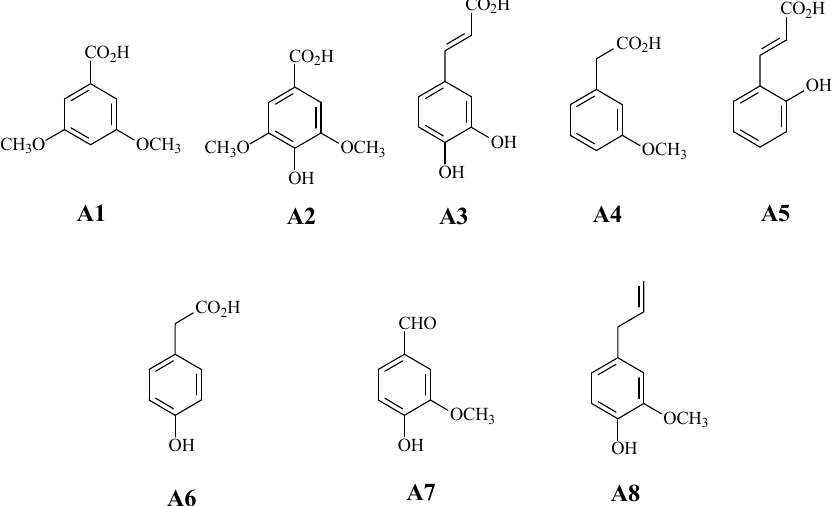
Figure 1. The phenyl-acyl compounds that were assayed in this work: 3,5-dimethoxybenzoic acid (A1, the code in this text), syringic acid (A2), caffeic acid (A3), 3-methoxyphenylacetic acid (A4), 2´-hydroxycinnamic acid (A5), 4´-hydroxyphenylacetic acid (A6), vanillin (A7), eugenol (A8), and, for copper sulfate, Cu(SO) 4 was assigned code A9.